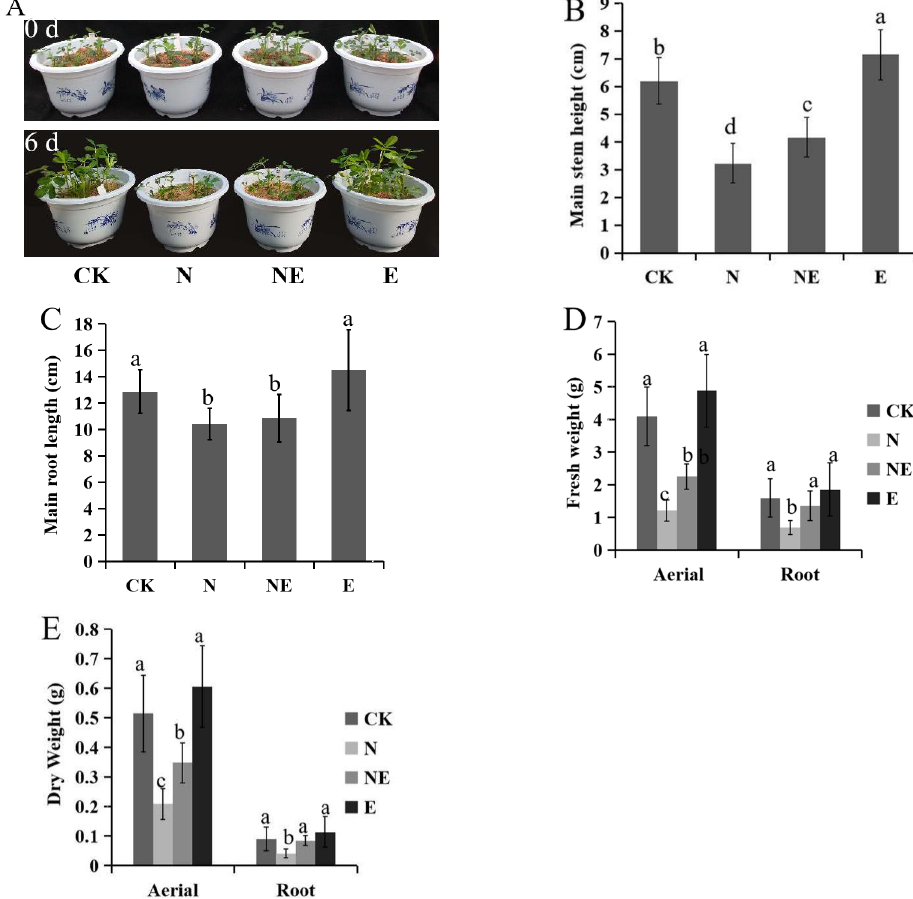
Figure 1. Effects of EBL on the growth of peanut seedlings under NaCl stress. CK (normal conditions), N (treated with 150 mM NaCl), NE (treated with 150 mM NaCl and 0.1 µM EBL) and E (treated with 0.1 µM EBL). ( A ) Seedling morphology; ( B ) Main stem height; ( C ) Main root length; ( D ) Seedling fresh weight; ( E ) Seedling dry weight. Different lowercase letters indicate significant differences between treatments ( p < 0.05). The same short forms were used in the figures below.